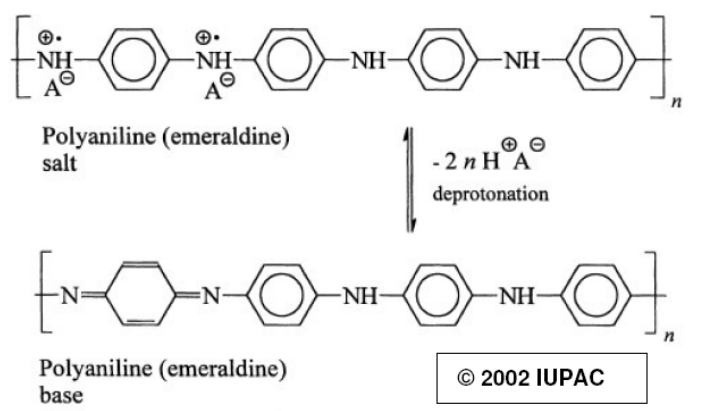
Figure 1. Polyaniline (emeraldine) salt is deprotonated in the alkaline medium to polyaniline (emeraldine) base. [A – is an arbitrary anion, e.g. chloride].